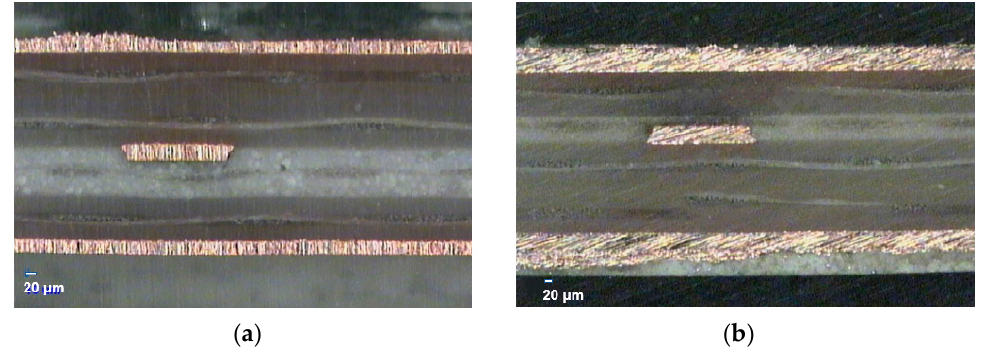
Figure 15. Cross-section of the fabricated striplines in ( a ) scenario 2 and ( b ) scenario 4.